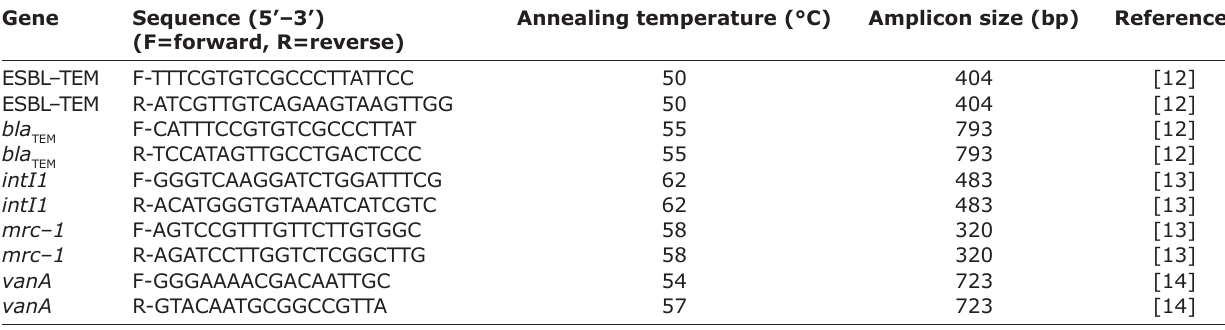
Table-1: The five gene specific primers used in this study. Gene Sequence (5’–3’) (F=forward,